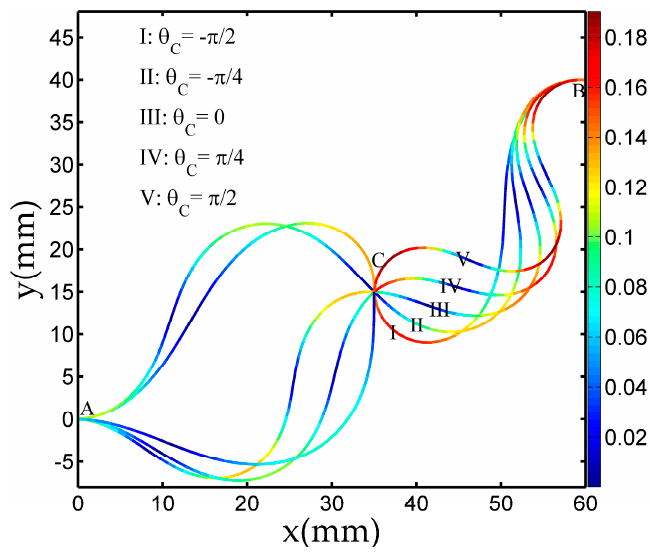
Figure 5. Optimized deformed shape of the three-point contact guidewire for different values of θ C .